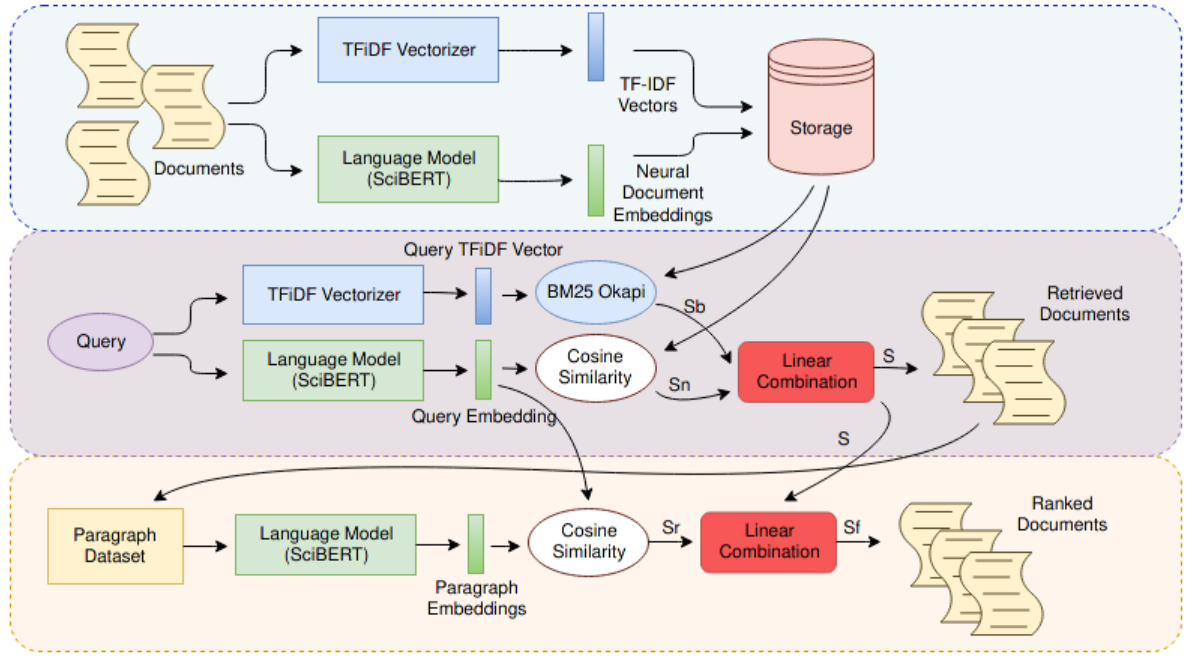
Figure 3. The picture shows the entire system from the dataset creation to the ranked documents. Inputs of the system are the documents to create data structures and queries. The system uses the same elements to treat documents or queries, and then it looks for documents related to the query using Neural Embeddings and the BM25 Okapi algorithm. After that, it sorts the retrieved papers using paragraph information. The ranked documents are the output of the